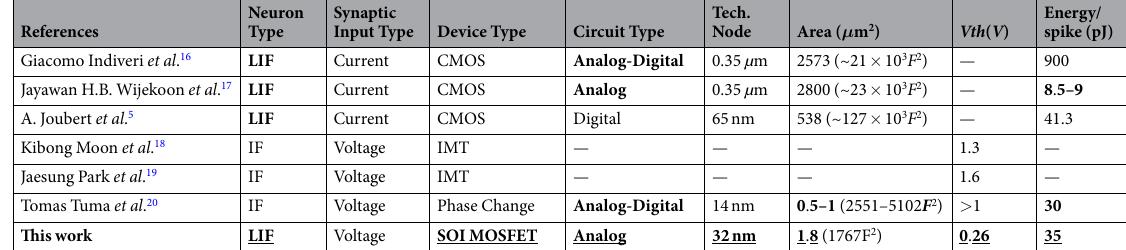
Table 1. Benchmarking with state-of-the-art electronic